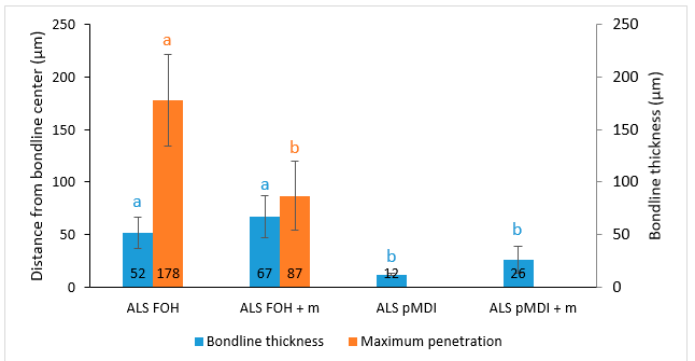
Figure 3. Bondline thickness (blue bars) and maximum penetration (orange bars) in 2-layered beech samples bonded with ammonium lignosulfonate (ALS) crosslinked with furfuryl alcohol (ALS FOH), ALS FOH with mimosa tannin (ALS FOH + m), ALS crosslinked with pMDI (ALS pMDI) and ALS pMDI with mimosa tannin (ALS pMDI + m). Each bondline thickness and maximum penetration column is the average of 15 and 30 determinations, respectively. Error bars represent standard deviations. Values labeled with different letters (a and b) are statistically different at an error probability of α = 0.05 (bondline thickness ANOVA and Tukey’s HSD tests, maximum penetration Welch Two Sample t-test).